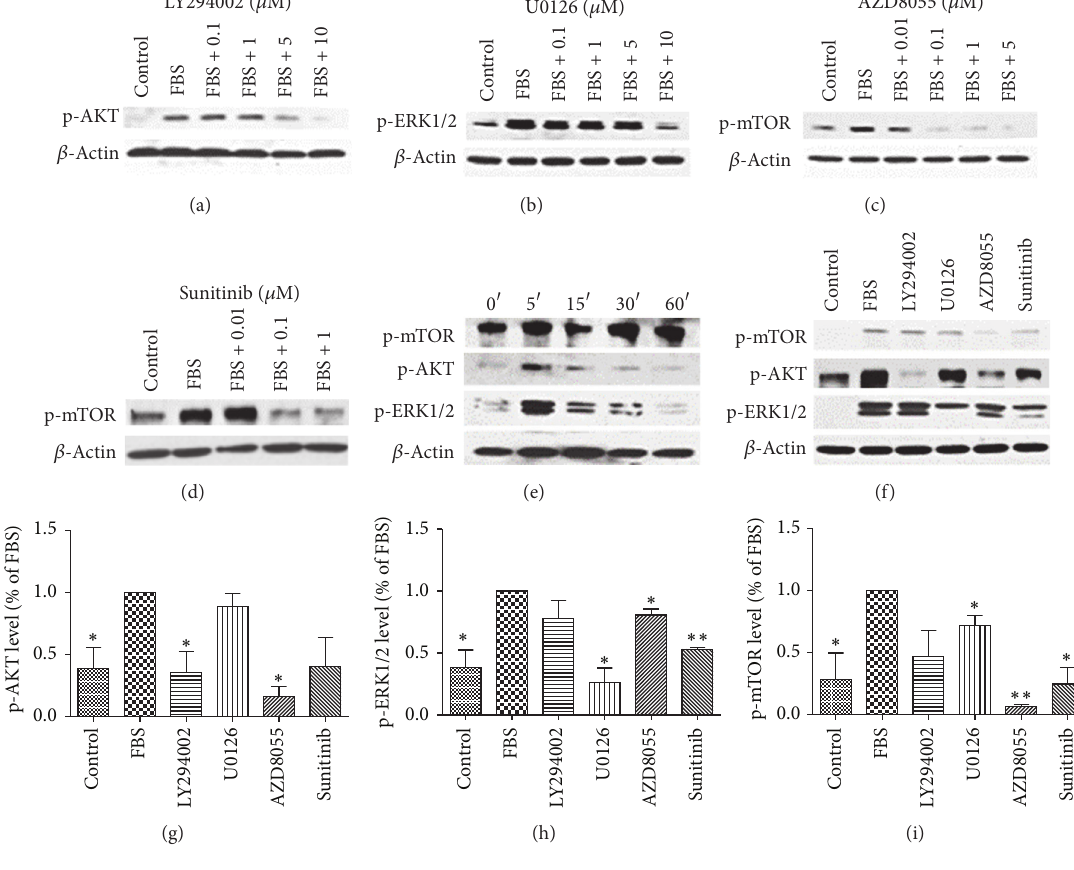
densitometric results of the phosphorylation from three independent experiments. ERK1/2, AKT, and mTOR phosphorylation in FBS group was taken as 100%. ∗ 𝑃 < 0.05 versus FBS group; ∗∗ 𝑃 < 0.01 versus FBS